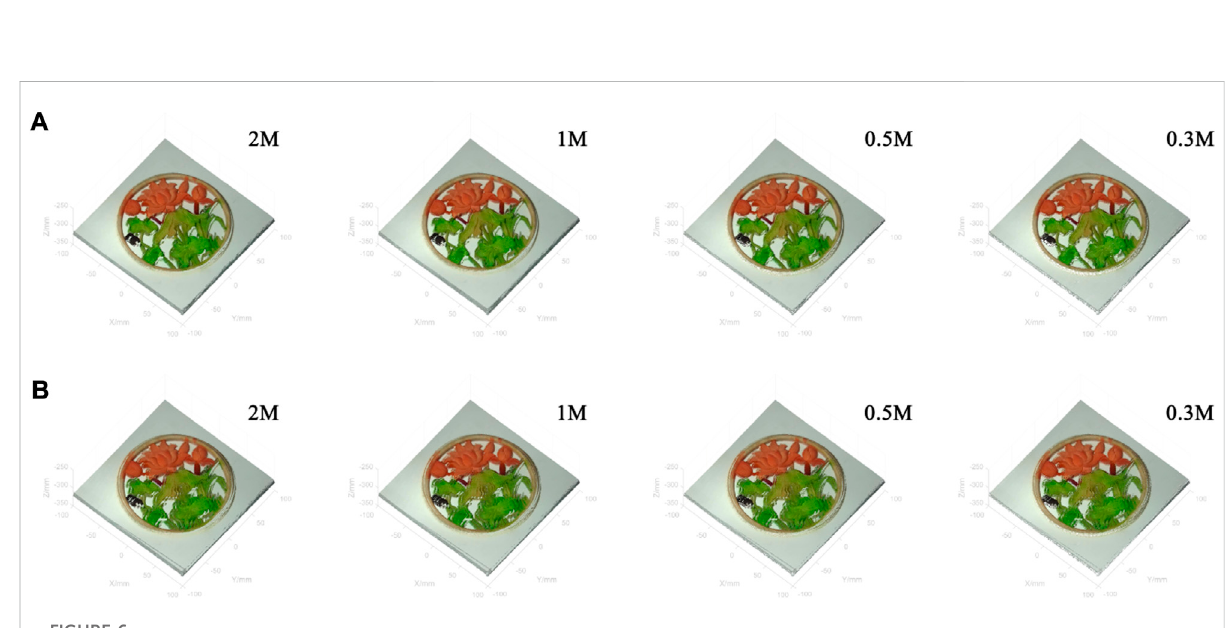
FIGURE 6 Registration results of different scale point clouds, (A) Our method, (B)